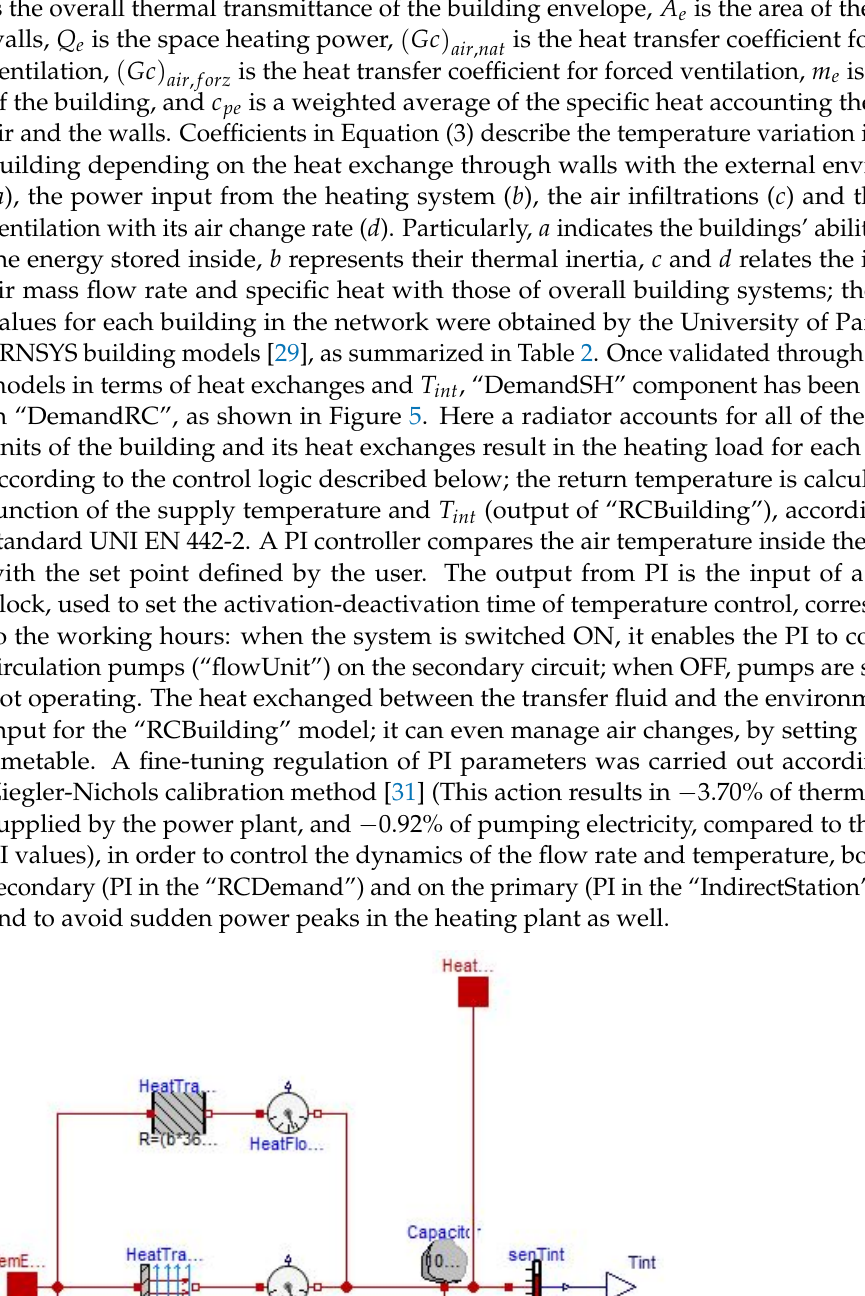
0.04378 Figure 5. Diagram view of “DemandRC” model component in Dymola. Figure 6. Diagram view of “Supply_pT” model component in Dymola. 2.3. Simulations: Analysed Scenarios and Optimization In order to optimise internal comfort conditions and, at the same time, to minimise energy consumption, different management scenarios were proposed and compared. A simulation time of eight weeks was chosen starting from the beginning of the heating sea- son [28], i.e., at 00:00 on 15 October (2018 for weather conditions) in Parma, Italy [32]. All